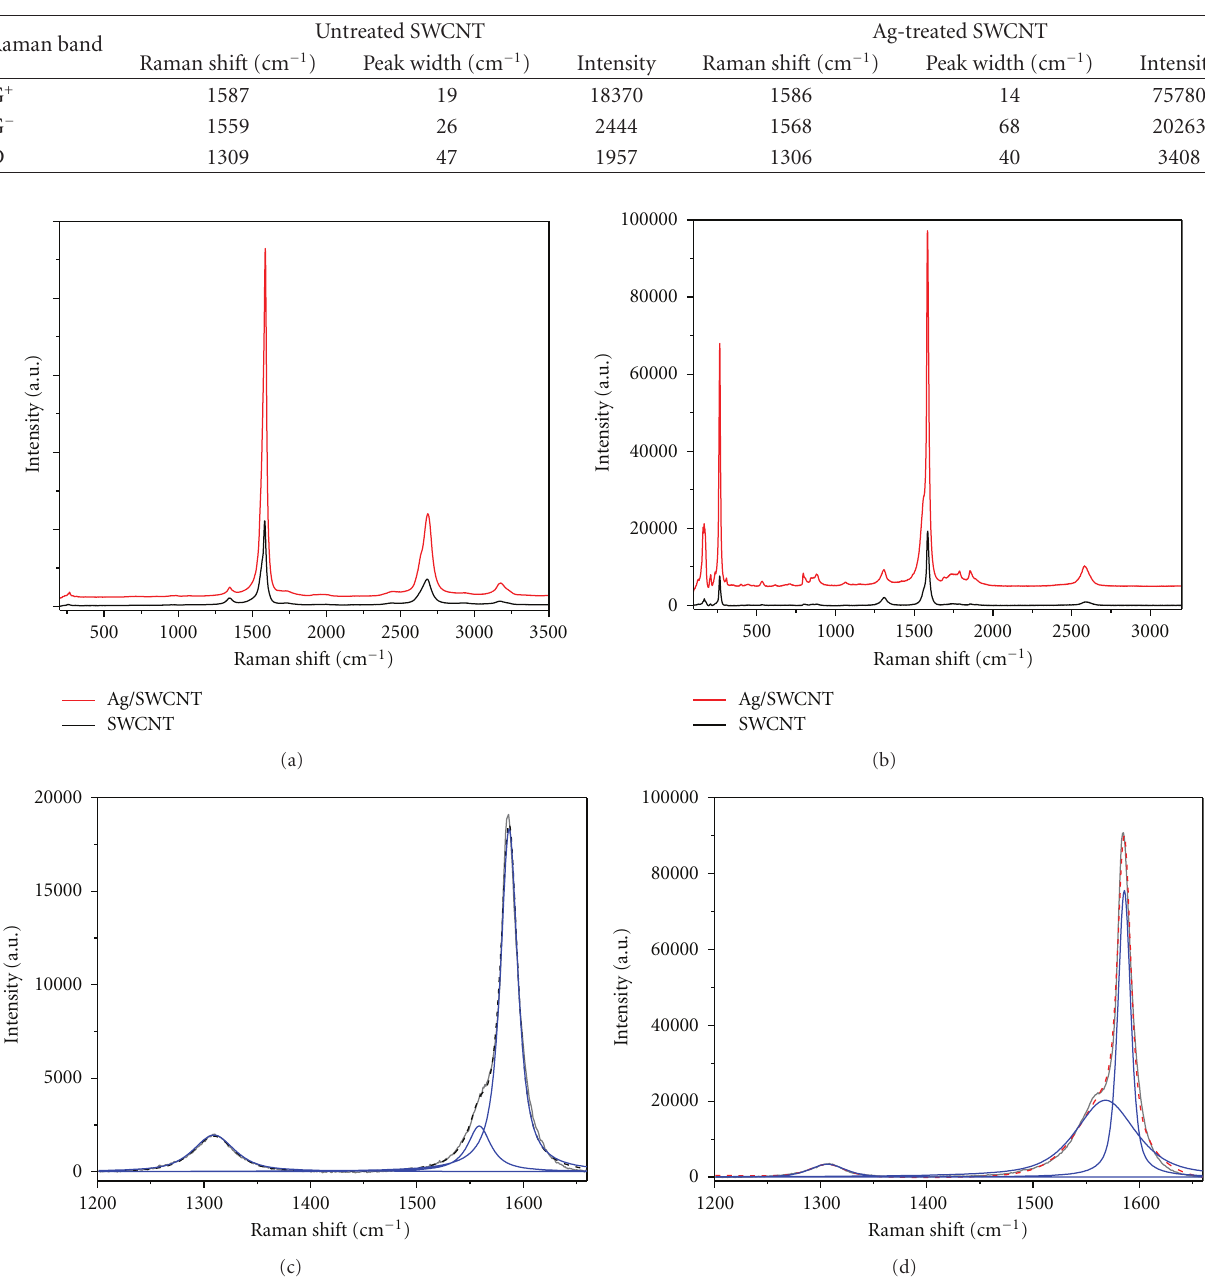
Table 1: Analysis of G and D Raman bands for untreated SWCNT and Ag-treated SWCNT for 1.58 eV.